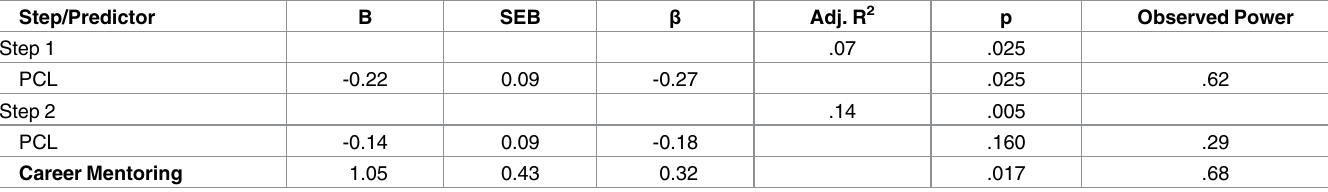
Table 3. Regression analysesfor hypothesis 4: Criterion variable for all analysesis Job in General (job satisfaction). Step/Predictor